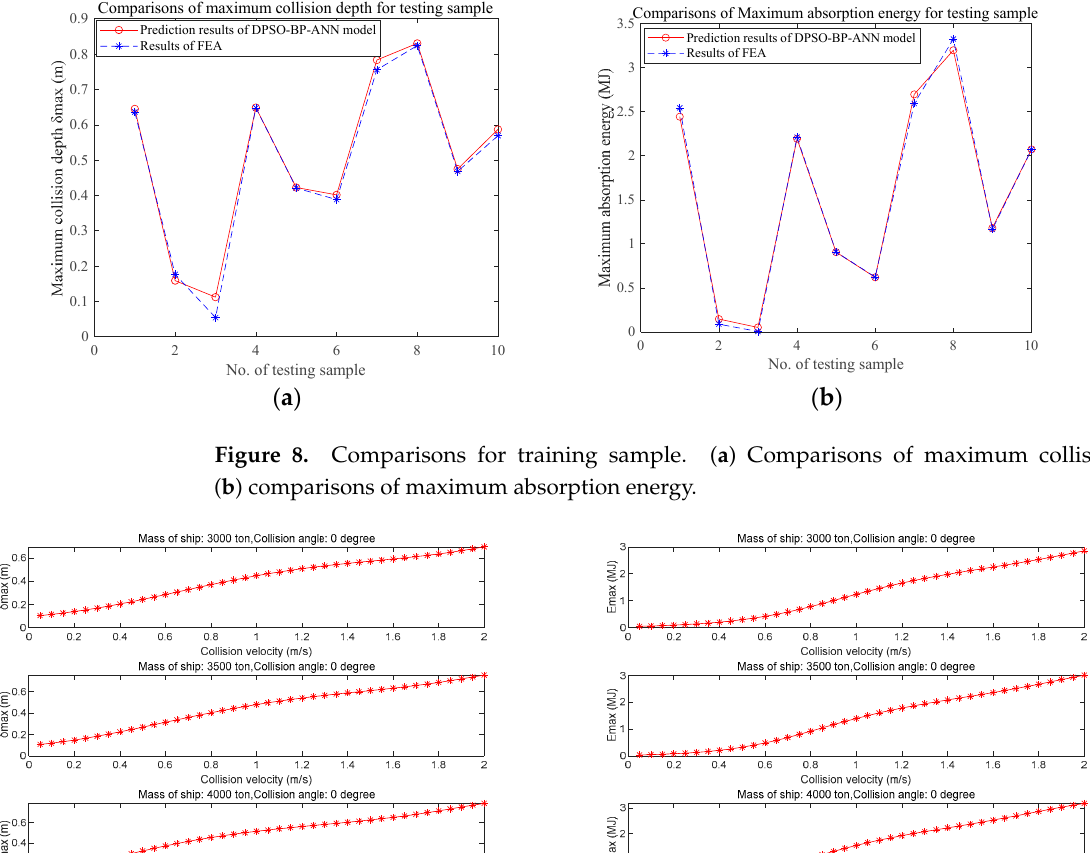
Figure 10. Curves of δ max and E max varying with the collision angle under 5 different collision velocities. 4.4. Evaluations of the Collision Reponse Prior to the conduct of the GRA evaluation the original data of collision responses are transformed to benefit-type and standardized data [36]. Then, as stated in Section 2.6,